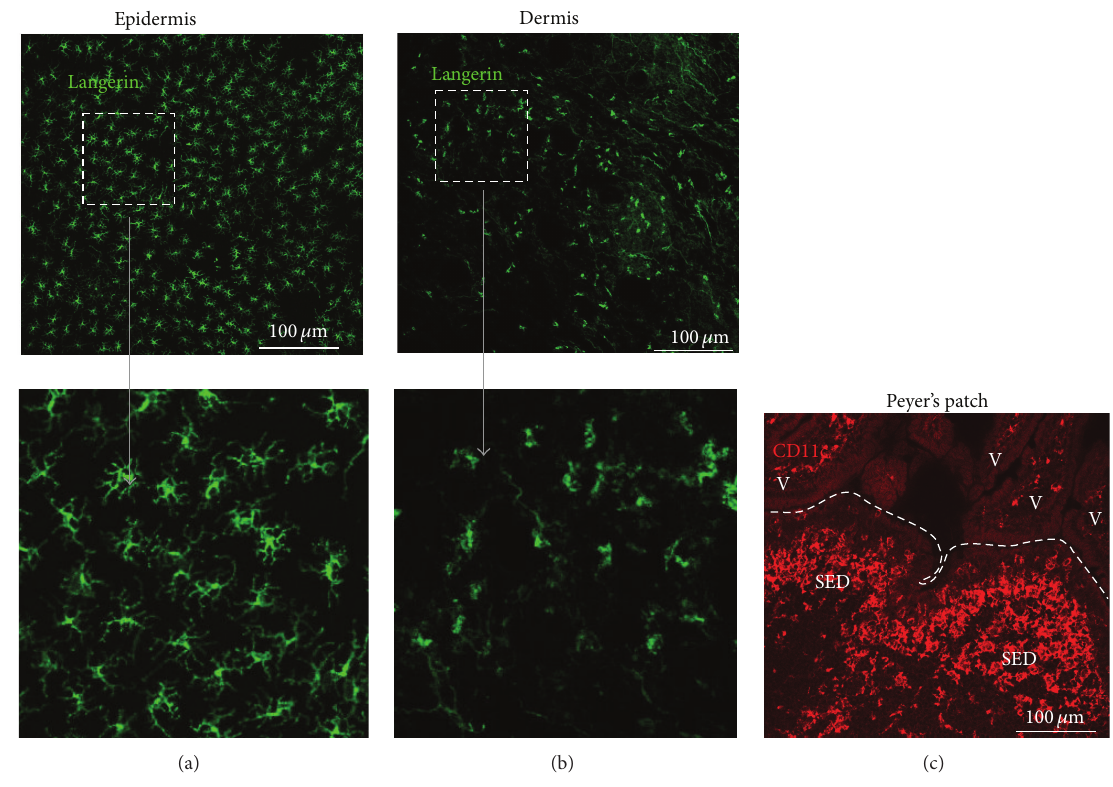
Figure 3: Mononuclear phagocytes (MNP) are a heterogeneous population of monocytes, macrophages, and dendritic cells and are abundant throughout the body. MNP are strategically situated at exposure sites such as in the epidermis or dermis of the skin (panels “(a)” and “(b),” resp.) and in the intestinal lamina propria where they provide a first line of defence against pathogens. (a and b) Whole-mount immunohistochemical detection of langerin + Langerhans cells in the epidermis (green, panels “(a)”) and langerin + conventional DC in the dermis (green, panels “(b)”). The boxed region in the upper panels is shown at higher magnification in the adjacent lower panels. (c) CD11c + MNP (red) are abundant in Peyer’s patches and the intestinal lamina propria. SED, subepithelial dome region on Peyer’s patch; V, villus; broken line indicates the boundary of the epithelium overlying Peyer’s